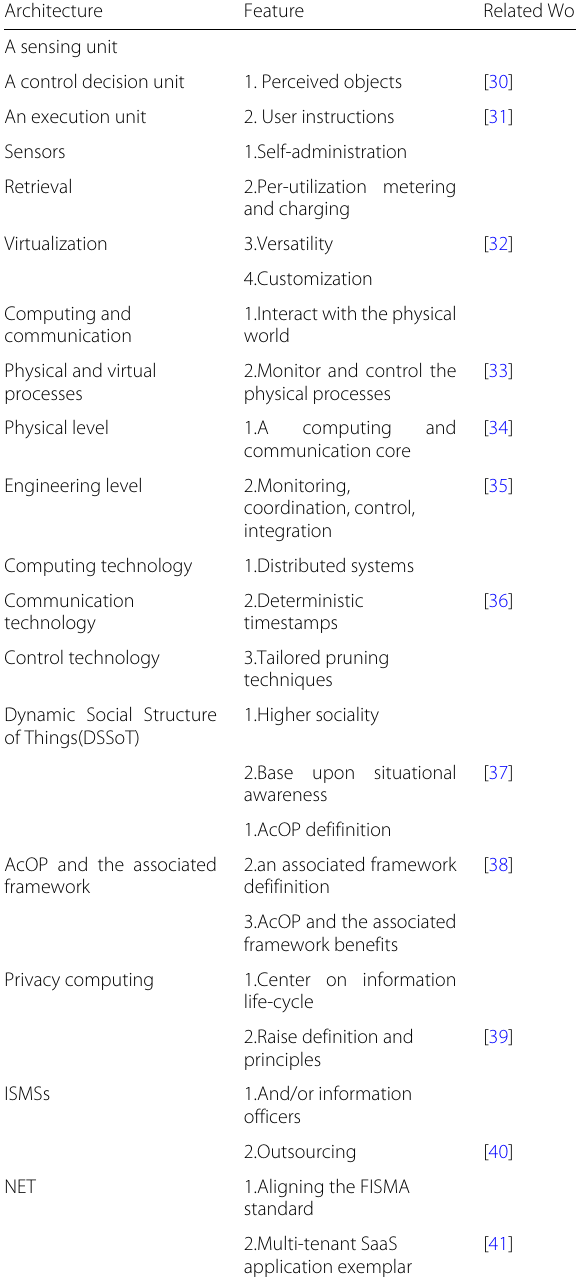
Table 2 Summary of literatures about framework of